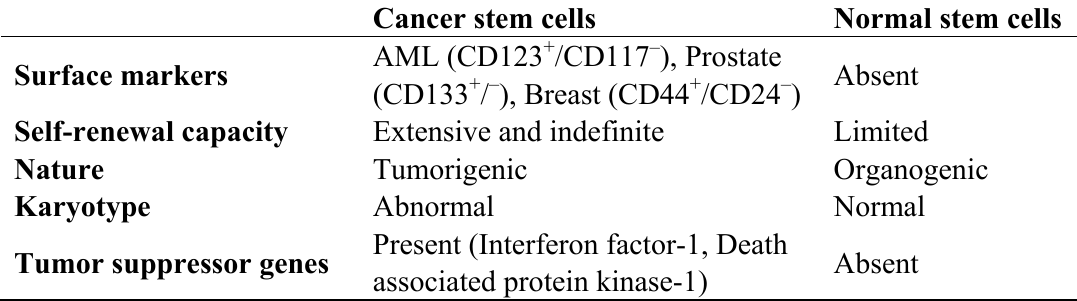
Table 2 . The differences between cancer stem and normal stem